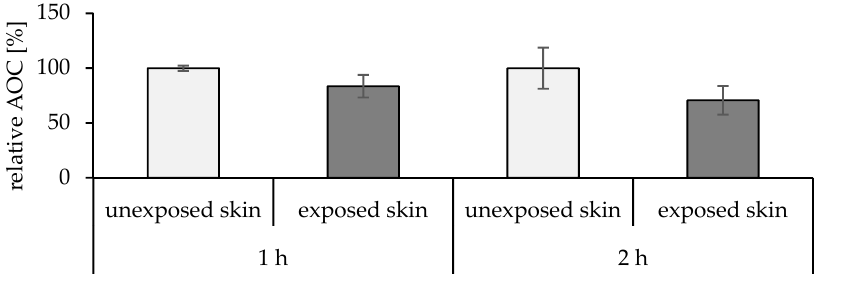
Figure 7. Effect of UV radiation on skin relative AOC for 1 h ( p = 0.0011) and 2 h ( p = 0.0064) compared to unexposed skin.